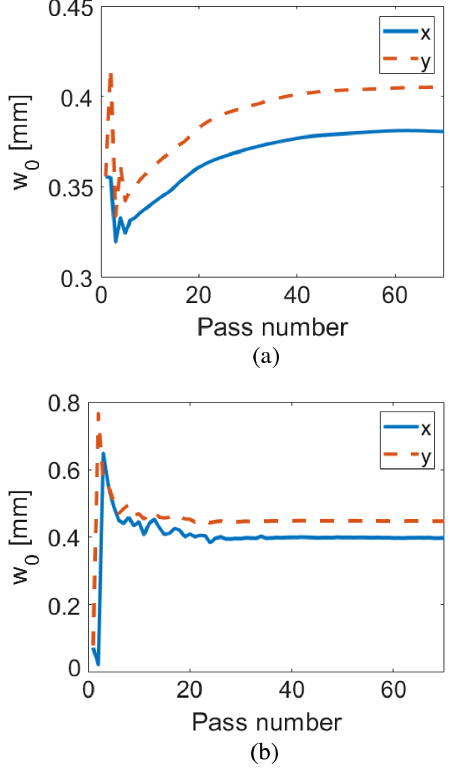
FIG. 11. The transverse size of a stored radiation pulse in the cavity per pass on the horizontal (x) and vertical (y) plane. (a) Case starting with an external seed laser. (b) Case starting from shot